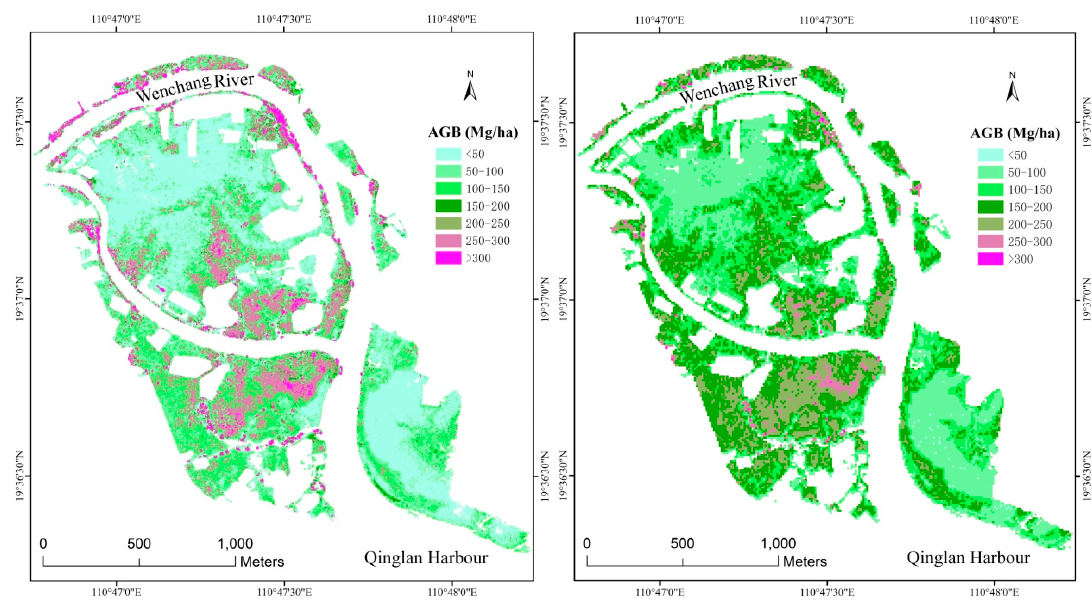
13 of 22 Figure 5. Accuracy comparison of AGB between the field estimated and predicted values. ( a ): Case 1, individual tree-based inference method. ( b ): Case 2, grid-based RF model method. 3.4. Spatial Distribution of Mangrove AGB The comparison of the resultant AGB maps derived from the individual tree-based inference method and the grid-based RF model method are presented in Figure 6. According to above accuracy assessment of the two methods, the spatial distribution of the mangrove AGB in the whole study area can be better represented by the grid-based RF model method based on LiDAR metrics than the individual tree-based inference method. While, the AGB map derived from the latter method was able to portray the AGB distribution at individual tree level for each mangrove species. The two mangrove AGB maps both show that the mangrove AGB hot spots lie in the southwest and middle of the study area, while the AGB cold spots lie in the southeast and north of the study area (Figure 6). There are also several conspicuous differences between these two maps. First, the low and middle AGB areas of the left map is overall lower than the low and middle AGB areas of the right map with one level difference. Second, the very high AGB areas (>300 Mg ha − 1 ) are more obvious in the left map and cover larger area than those in the right map. Third, the AGB values in the left